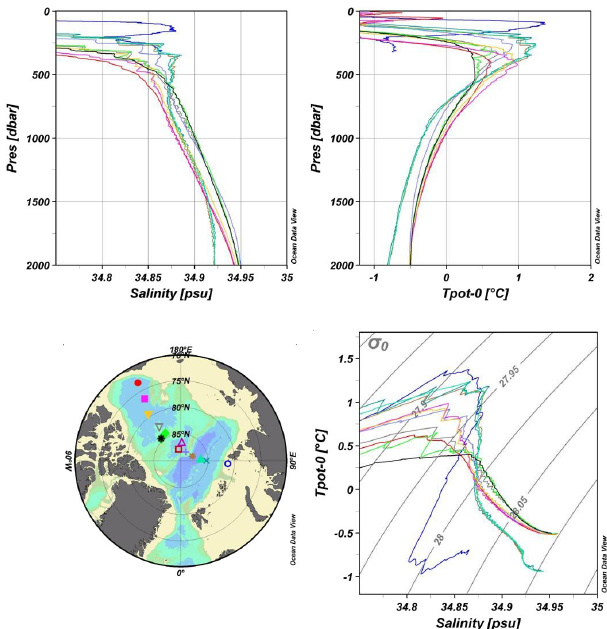
Fig. 14 . Profiles of salinity and potential temperature and θS curves showing the properties of the Barents Sea branch and the char- acteristics of the water column in the Amundsen Basin, Makarov Basin and Canada Basin and over the Lomonosov Ridge and over the Mendeleev and Alpha ridges. The Barents Sea branch is warm enough to supply the temperature maximum in most of the Arctic Ocean basins.